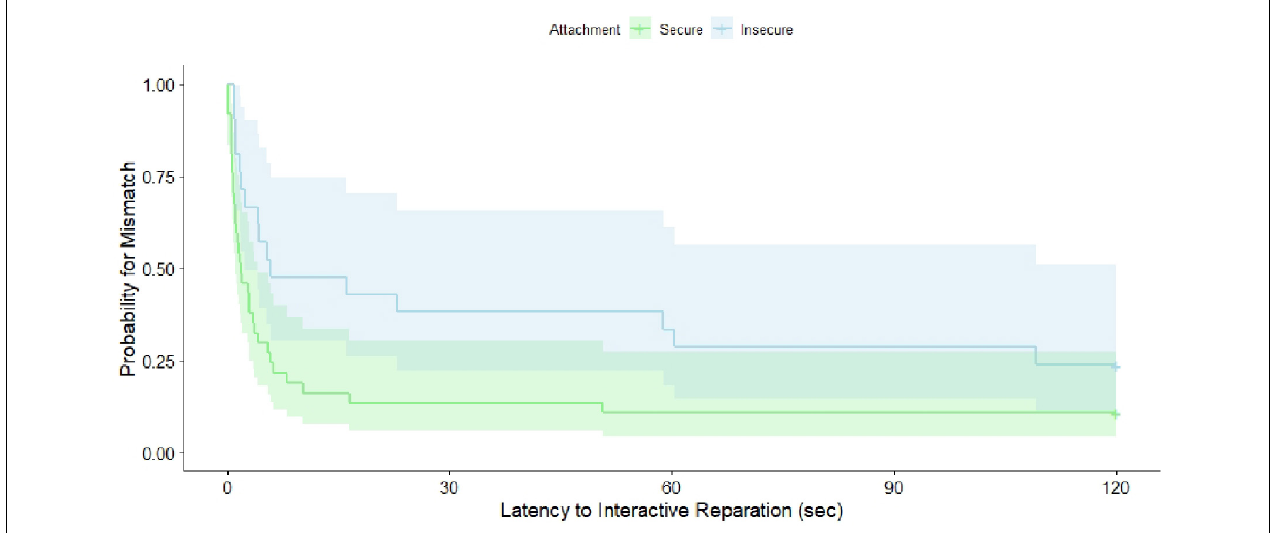
FIGURE 1 | Survival plot on time-dependent match stratified by later secure vs. insecure attachment